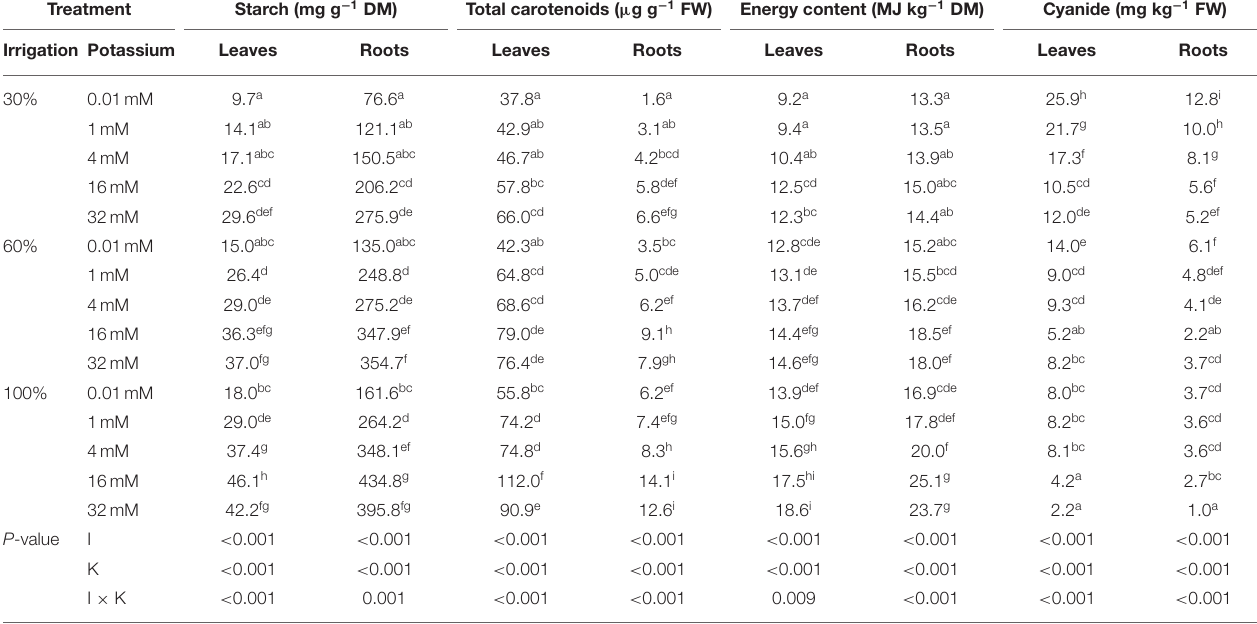
TABLE 1 | Starch, total carotenoids, energy, and cyanide concentration in leaves and roots of 90-day-old cassava plants in response to deficit irrigation and potassium fertigation.